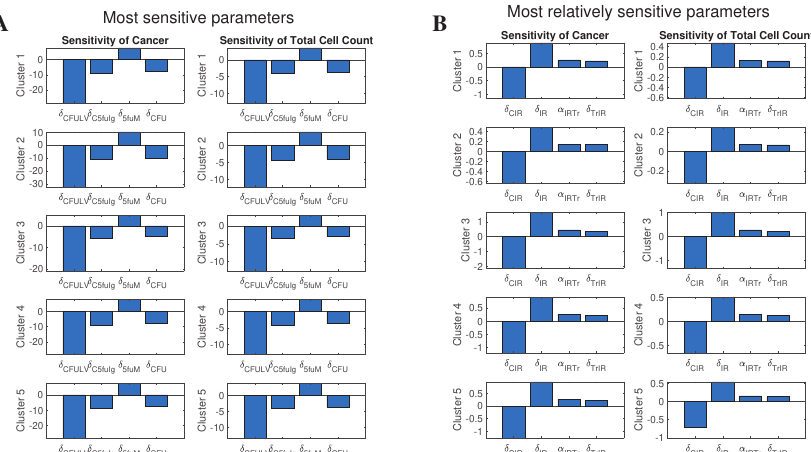
Figure 8. Sensitivity analysis. The first and second columns of ( A ) respectively present the results of non-dimensional sensitivity of cancer cell density and total cell density. ( B ) shows the relative sensitivity of the same quantities. Each row of plots shows the most sensitive parameters for each cluster of patients.